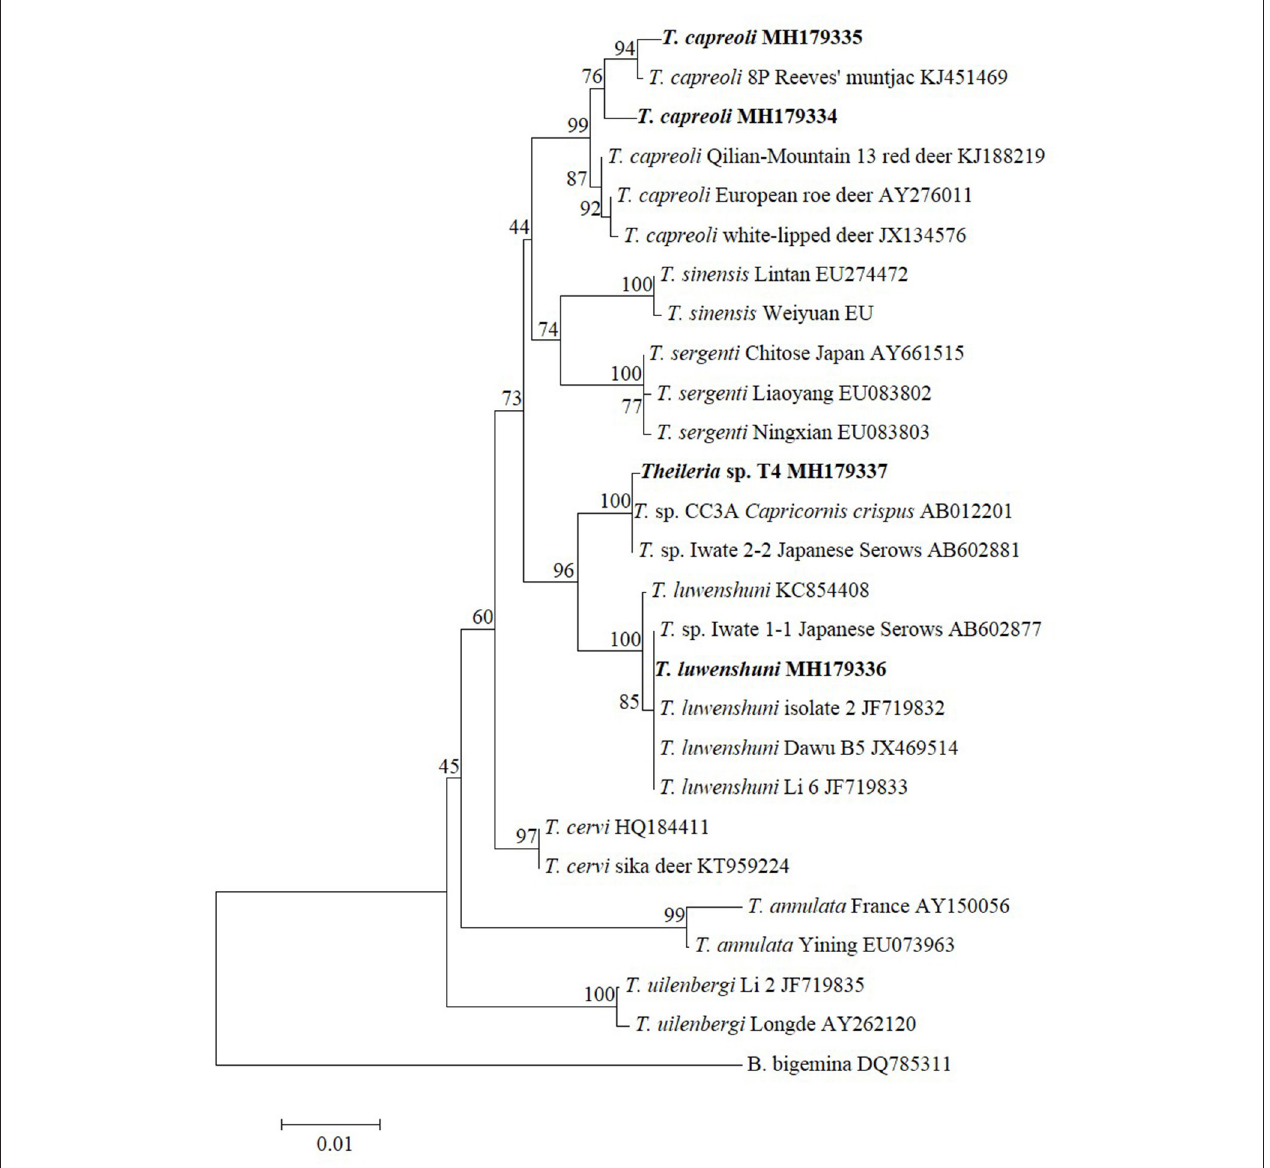
FIGURE 1 | Phylogenetic analysis of the Theileria species identified in this study based on the 18S rRNA gene. Babesia bigemina was used as outgroup. Boldface indicate the sequences obtained in this